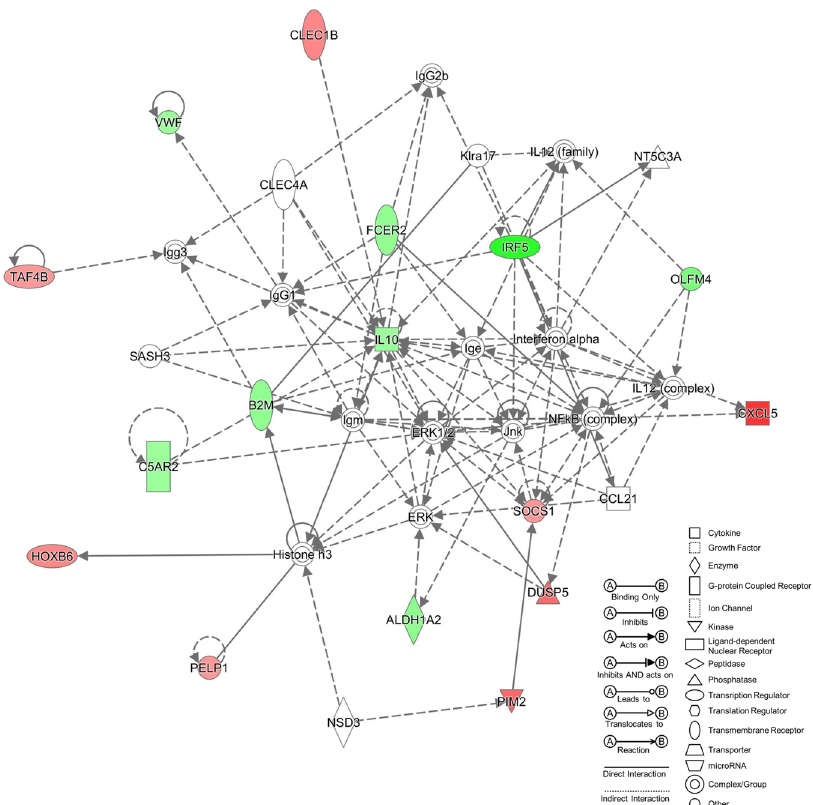
Figure 3. Top Network from MD patients PBMCs at basal levels. Network retrieved after comparing by pairwise analysis gene expression data from MD patients PBMCs with high and low basal levels of IL-1 β . Genes in red were up-regulated, while genes in green were